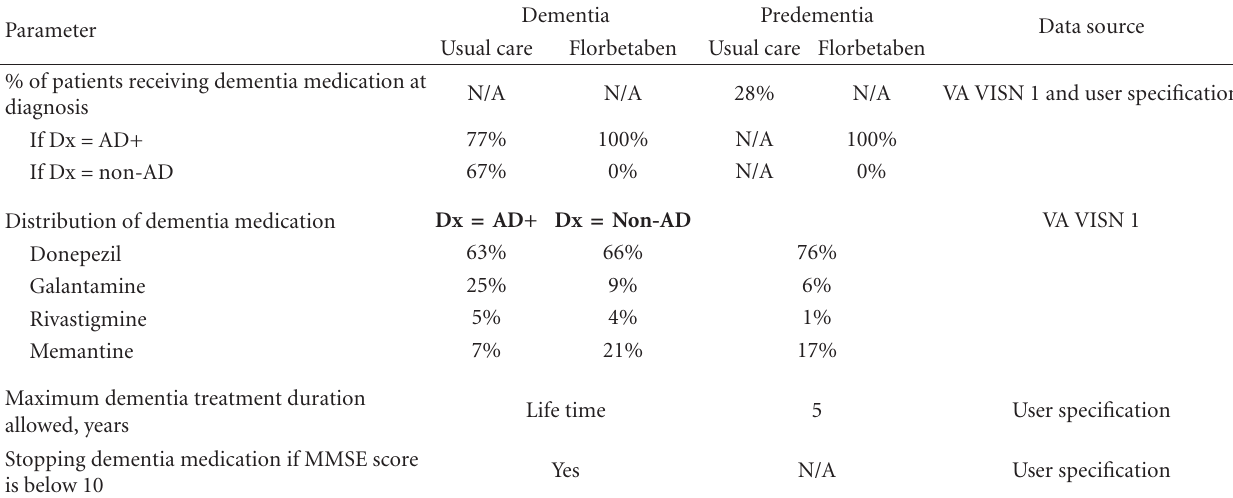
Table 3: Model parameters for